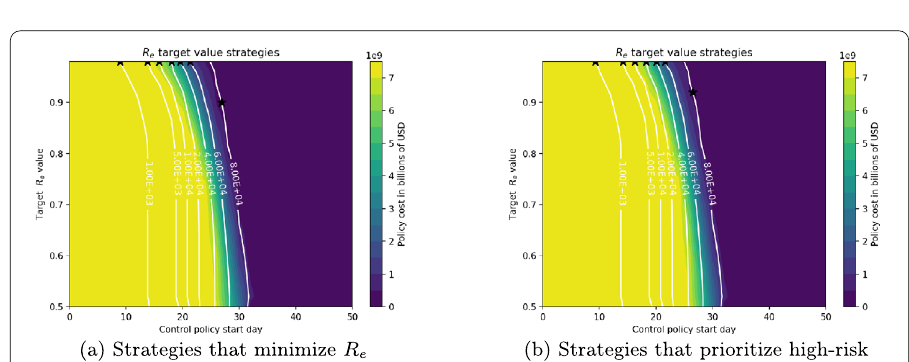
Figure 14 Deaths number and costs depending on target R e value and control starting day strategies